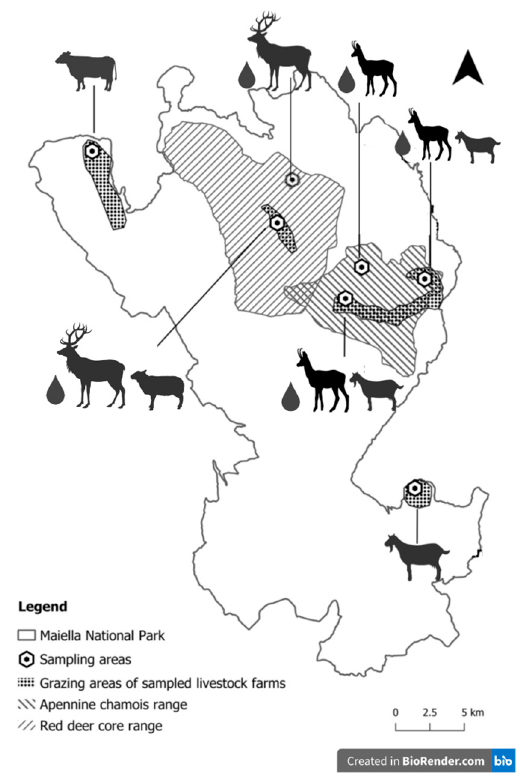
Figure 1. Distribution of the sampling areas in Maiella National Park.